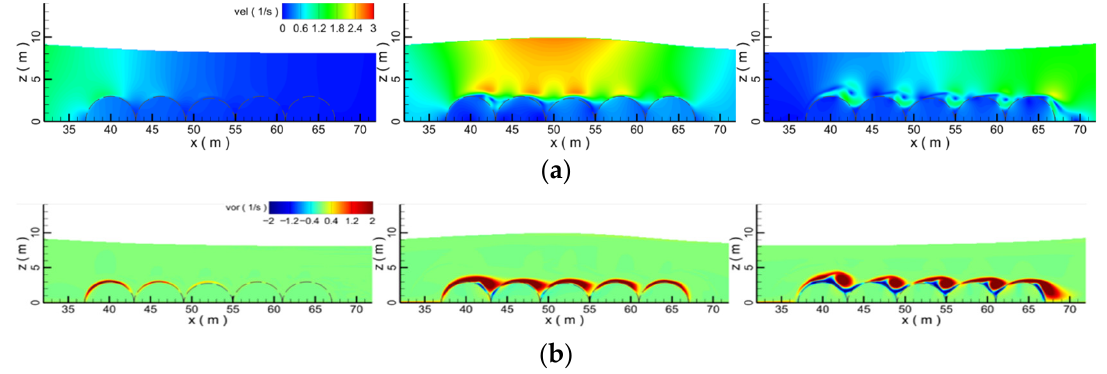
Figure 5. The flow filed around the breakwaters at different times; ( a ) velocity contour; ( b ) vorticity contour.